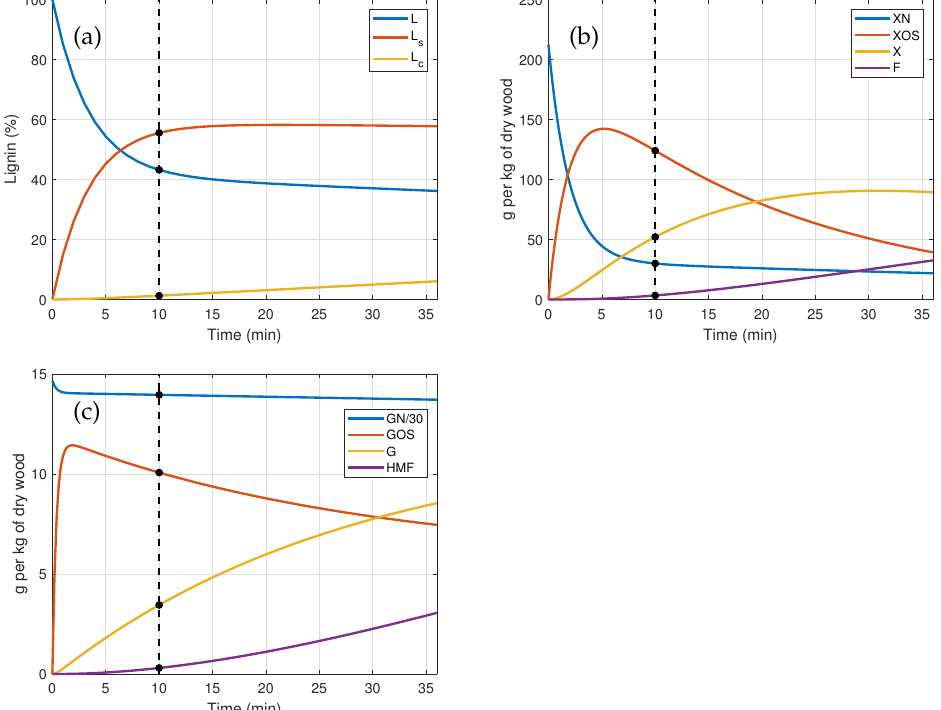
Figure 8. Steam refining: ( a ) Solubilised and solid-state lignin. ( b ) Xylan and its derivatives. ( c ) Glu- can and its